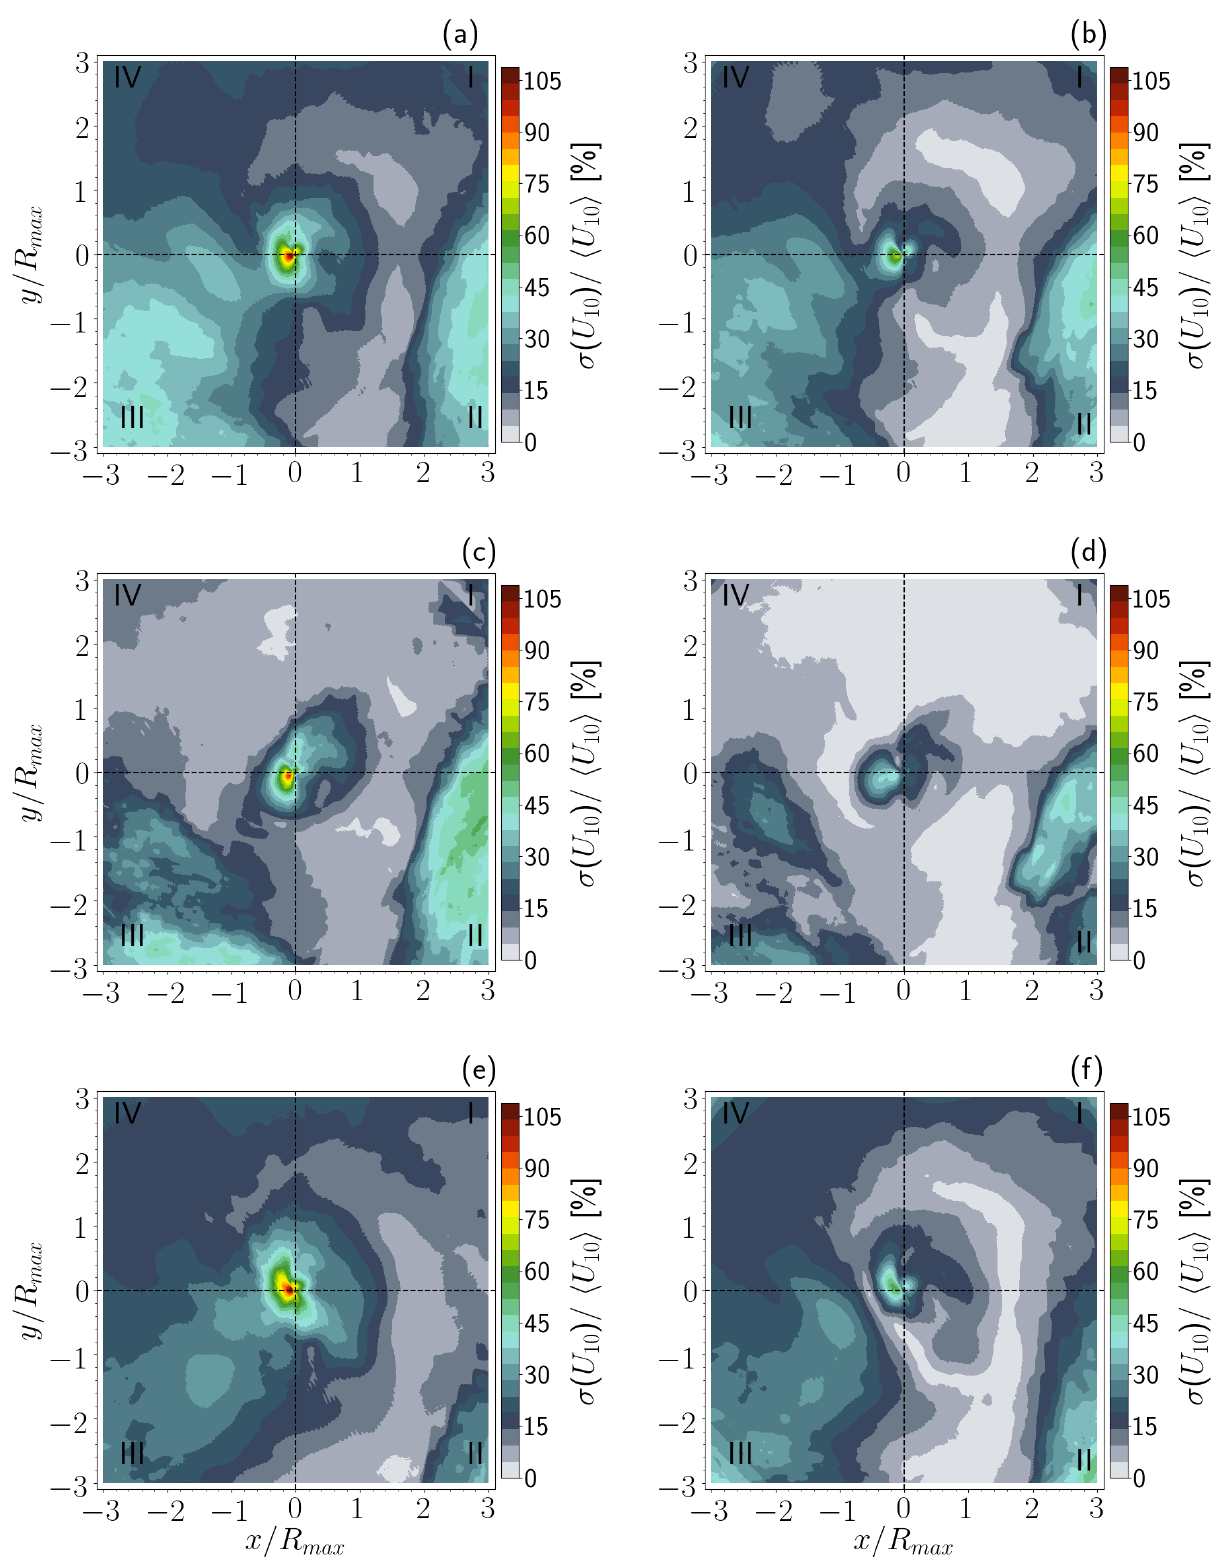
Figure 9. Temporal variability of the wind field computed with the original ( left ) and filtered ( right ) data. The panel levels represent the 18 h scheme ( top ), moderate storm ( center ) and intensifi- cation ( bottom ) stages. ( a ) and ( b ) show the average for the total period (18 h); ( c ) and ( d ) show the period of moderate storm (9 h), and ( e ) and ( f ) show the intensification period (9